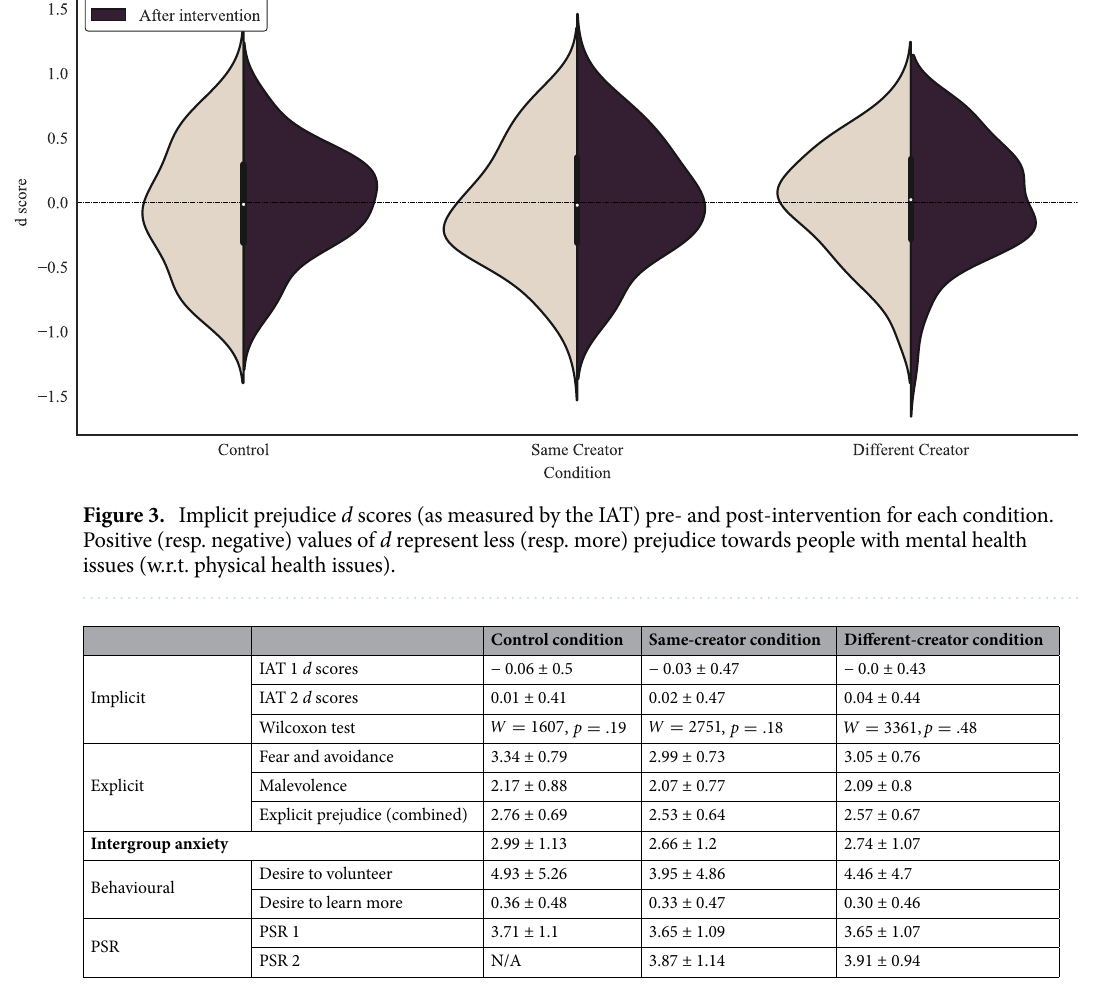
Table 2. Descriptive statistics on our sample (mean ± standard deviation), by condition, across measures of prejudice and PSR.